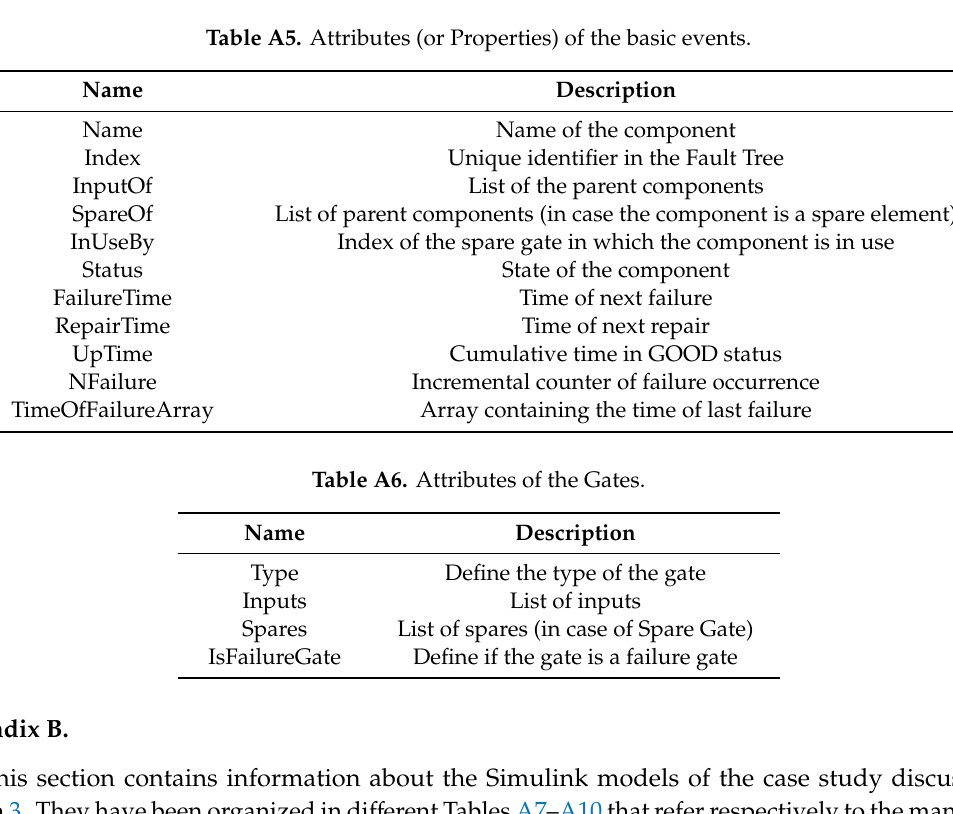
Table A5. Attributes (or Properties) of the basic events.